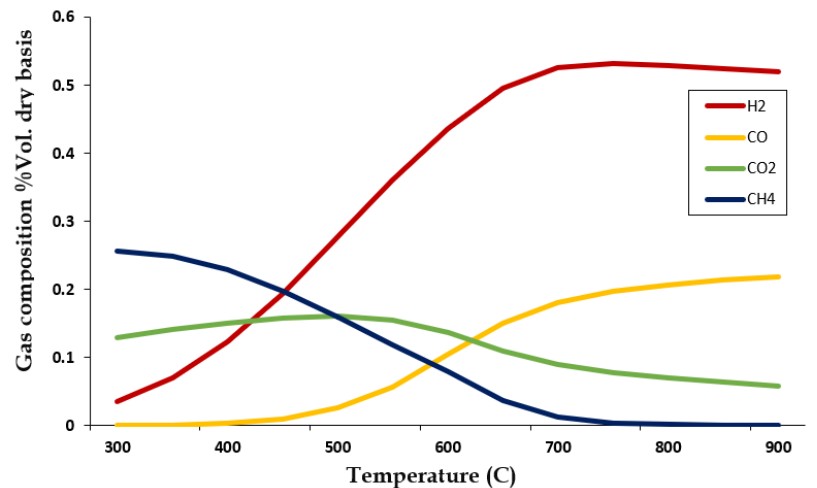
Figure 4. Effect of gasifier temperature on the syngas yield.